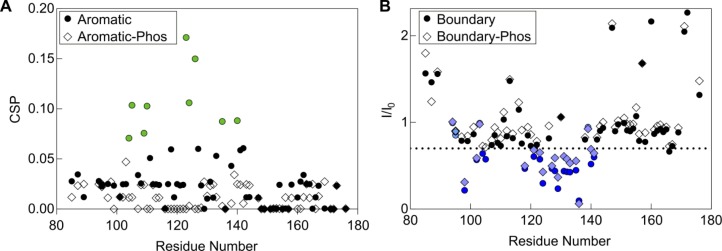
Effect of phosphorylation on peptide binding.(A) CSPs in the aromatic peptide binding experiment with 15N-B1-ACD. A phosphorylated form of the aromatic peptide with phophoserine at position 15 does not cause strong CSPs (diamonds), indicating that phosphorylation disrupts binding of this peptide to the ACD. (B) NMR intensity loss in boundary region peptide binding experiment with B1-ACD. A peptide with phosphoserine at positions 78 and 82 caused similar perturbations to the non-phosphorylated peptide, indicating that phosphorylation does not have a direct effect on this interaction. Colored points lost >30% intensity, had CSPs over 0.5, or both.